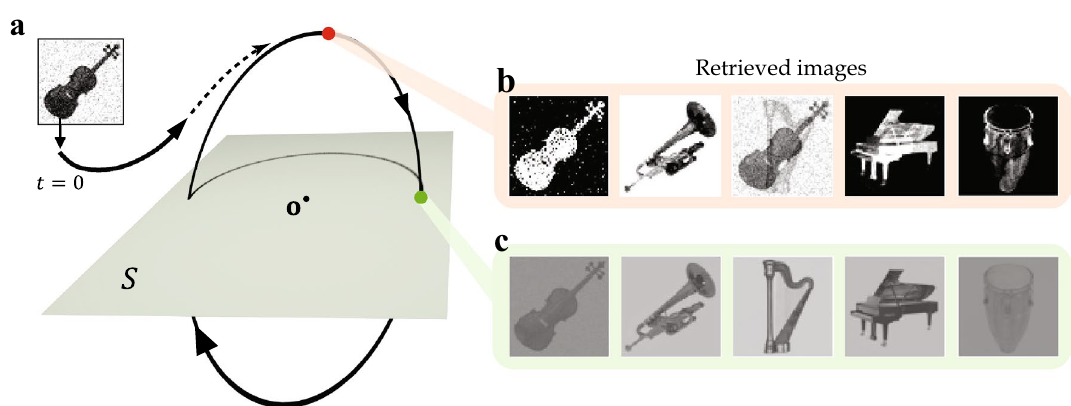
Figure 3. Auto-associative memory retrieval from a contaminated cue. ( a ) The noisy cue m c =